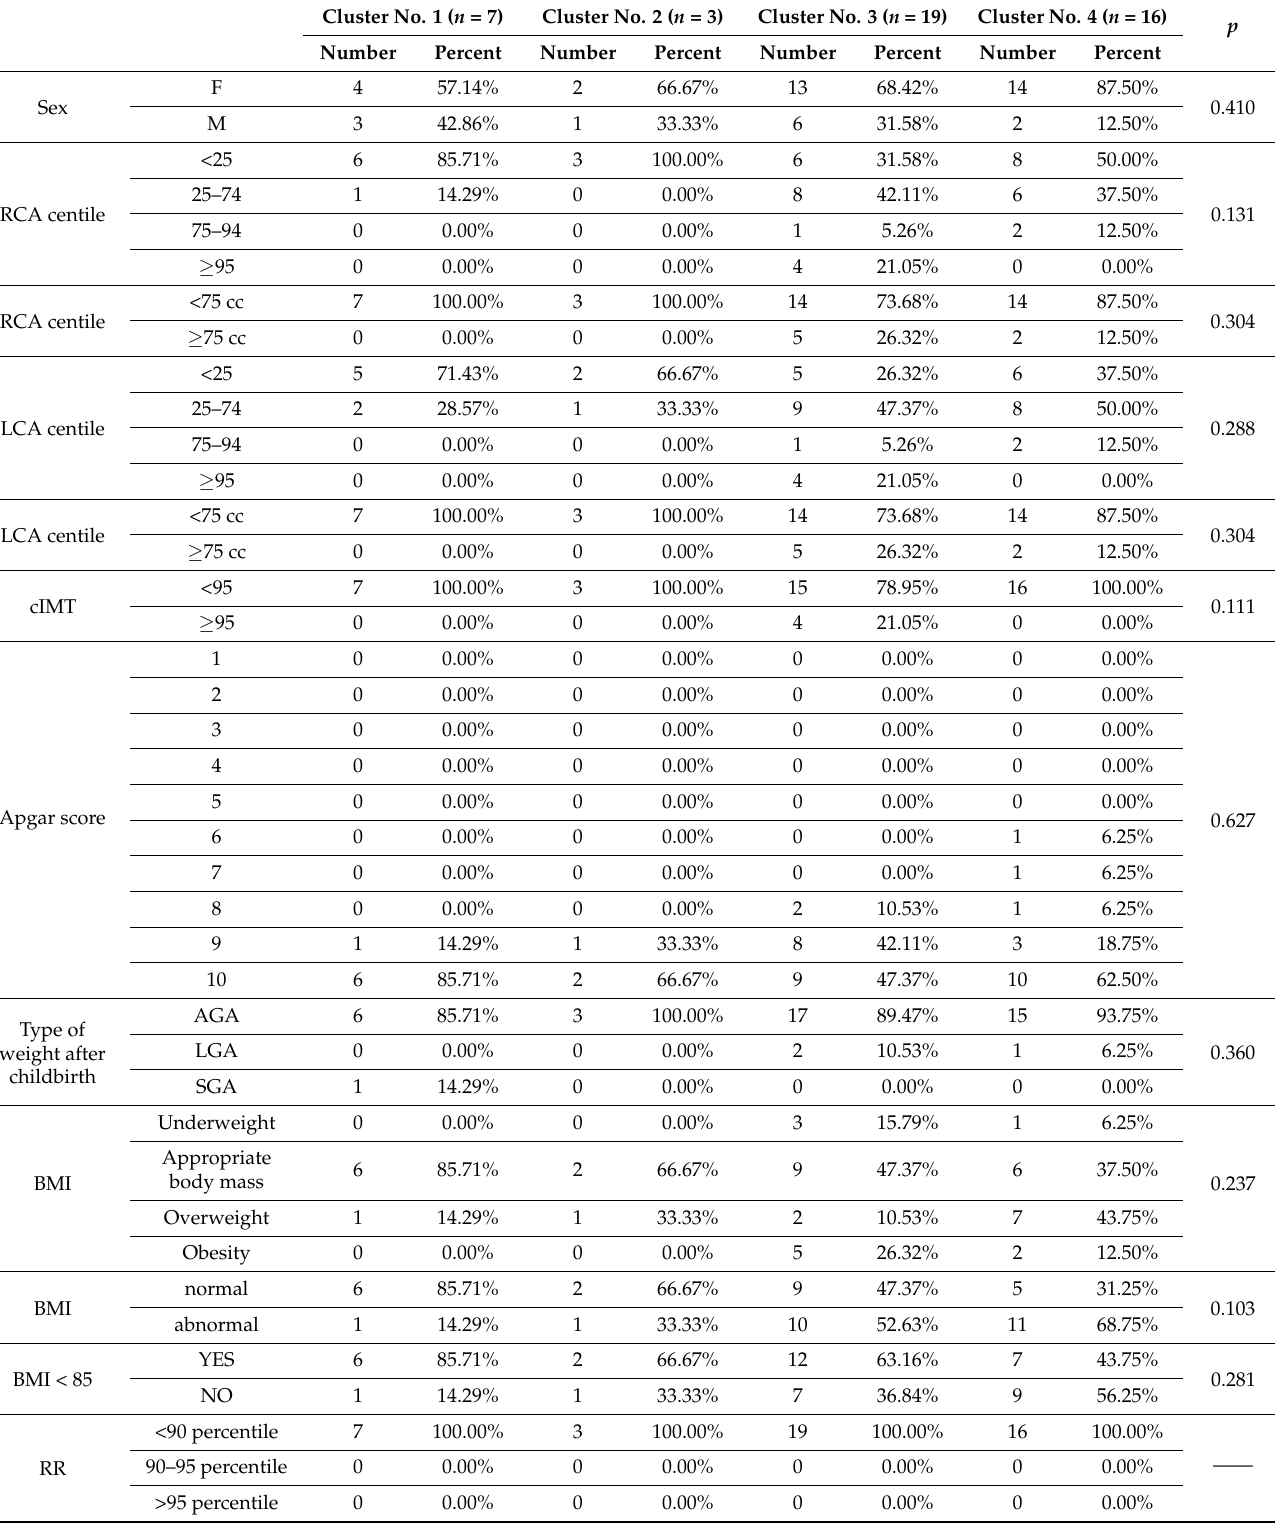
Table 4. Number of cases in the study group by diet-related